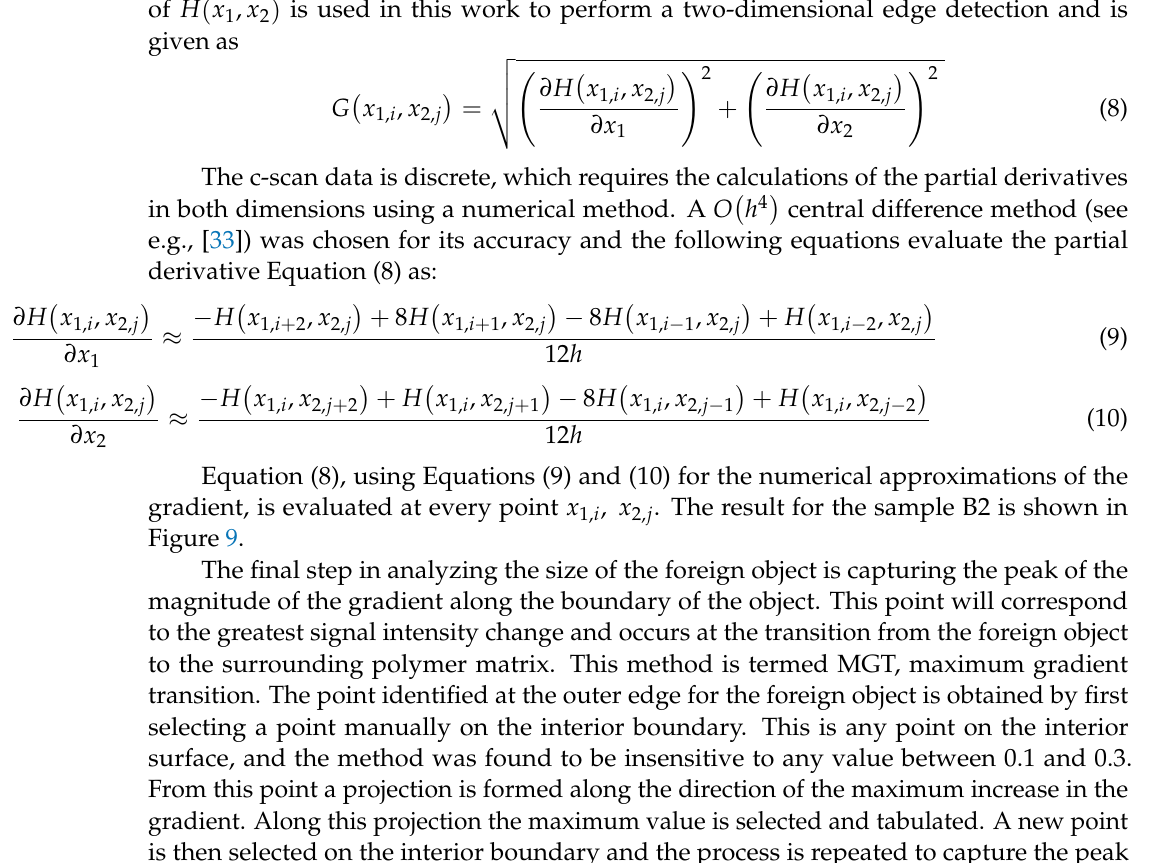
Figure 8. C-Scan of sample B2 after applying both smoothing and interpolation. Color indicates the normalized amplitude of the ultrasonic data.